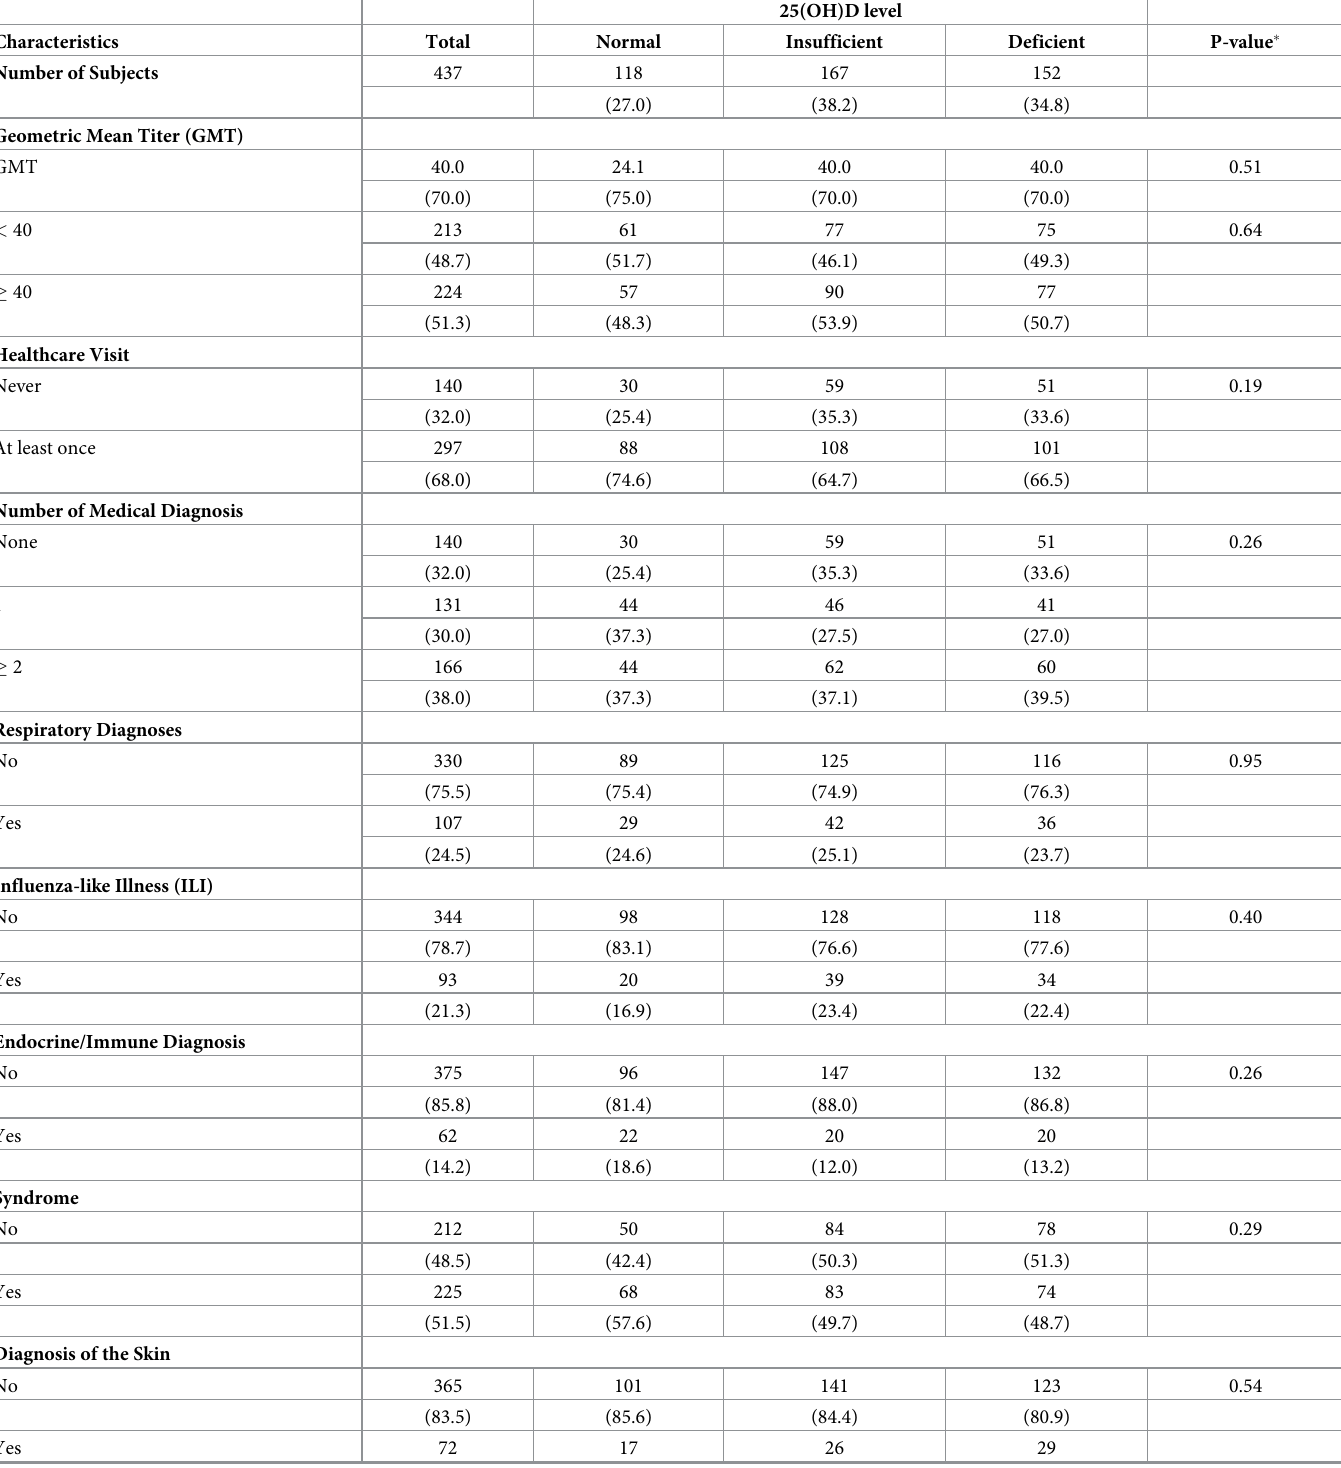
Table 2. Outcomes of GMT titers and medical diagnoses by serum 25(OH)D